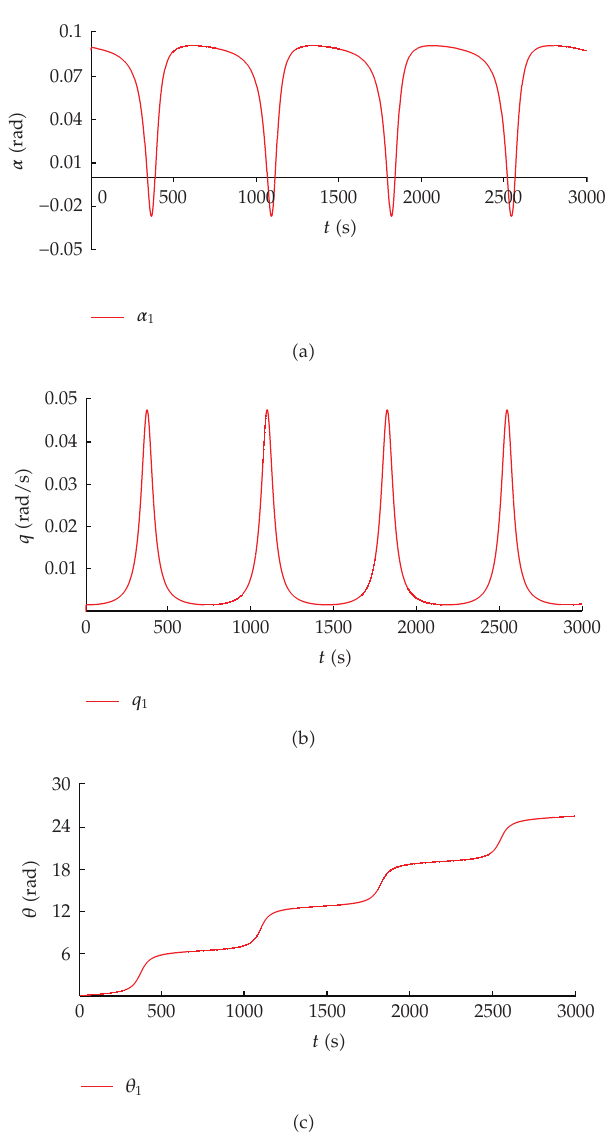
(cid:7) − 0 . 04678 (cid:5) rad (cid:6) (cid:7) − 2 . 68 ◦ → δ (cid:6)(cid:6) (cid:7) − 0 . 05 (cid:5) rad (cid:6) (cid:7) − 2 . 866 ◦ and the starting e e (cid:7) 0 (cid:5) rad / sec (cid:6) ; θ (cid:6) (cid:7) 0 . 159329 (cid:5) rad (cid:6) (cid:7) 9 . 133 ◦ 1 1